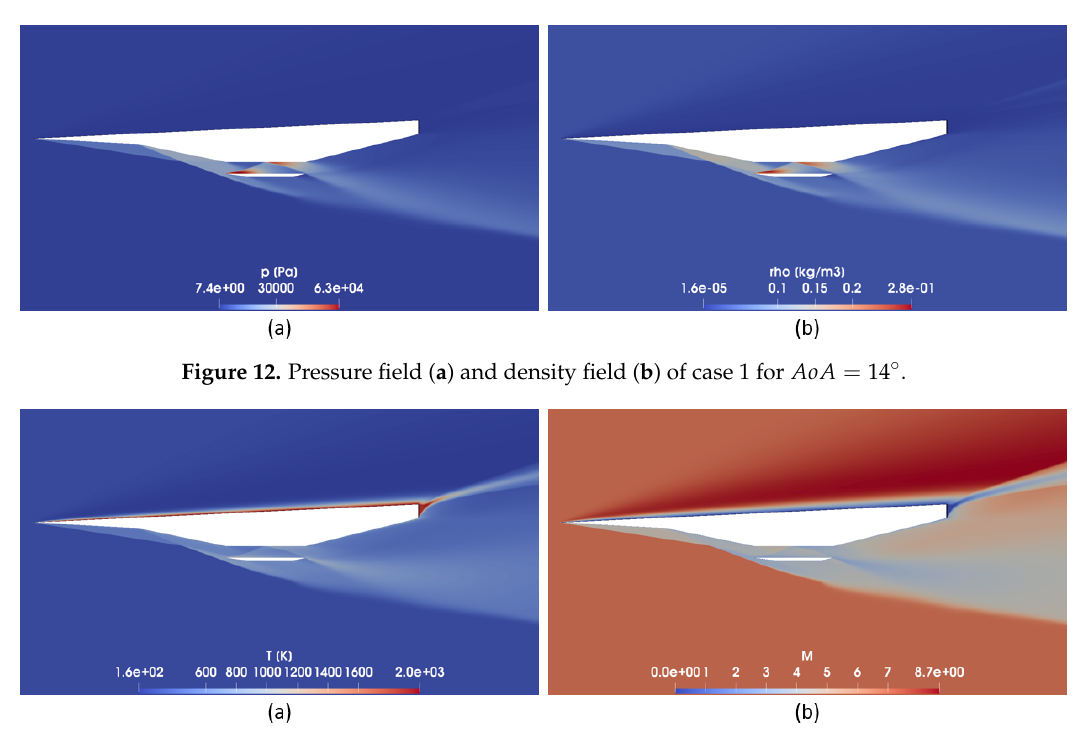
Figure 13. Temperature field ( a ) and Mach field ( b ) of case 1 for AoA = 14 ◦ .